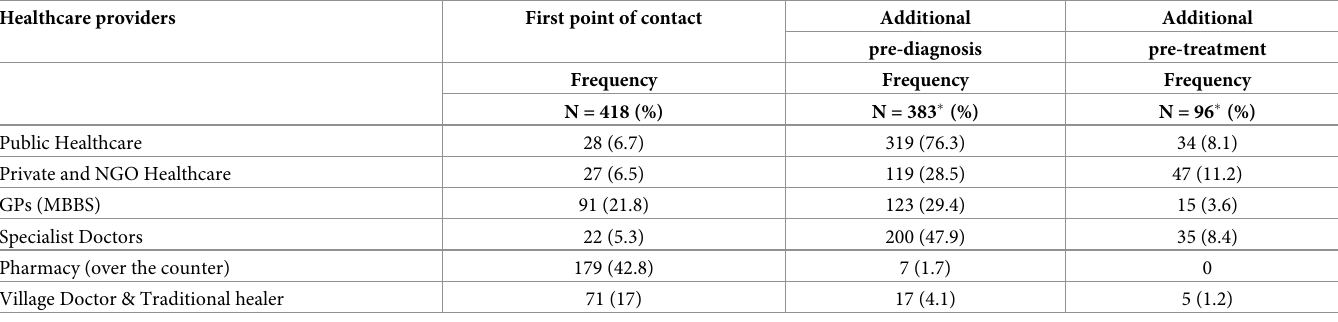
Table 4. Contact with healthcare providers at different